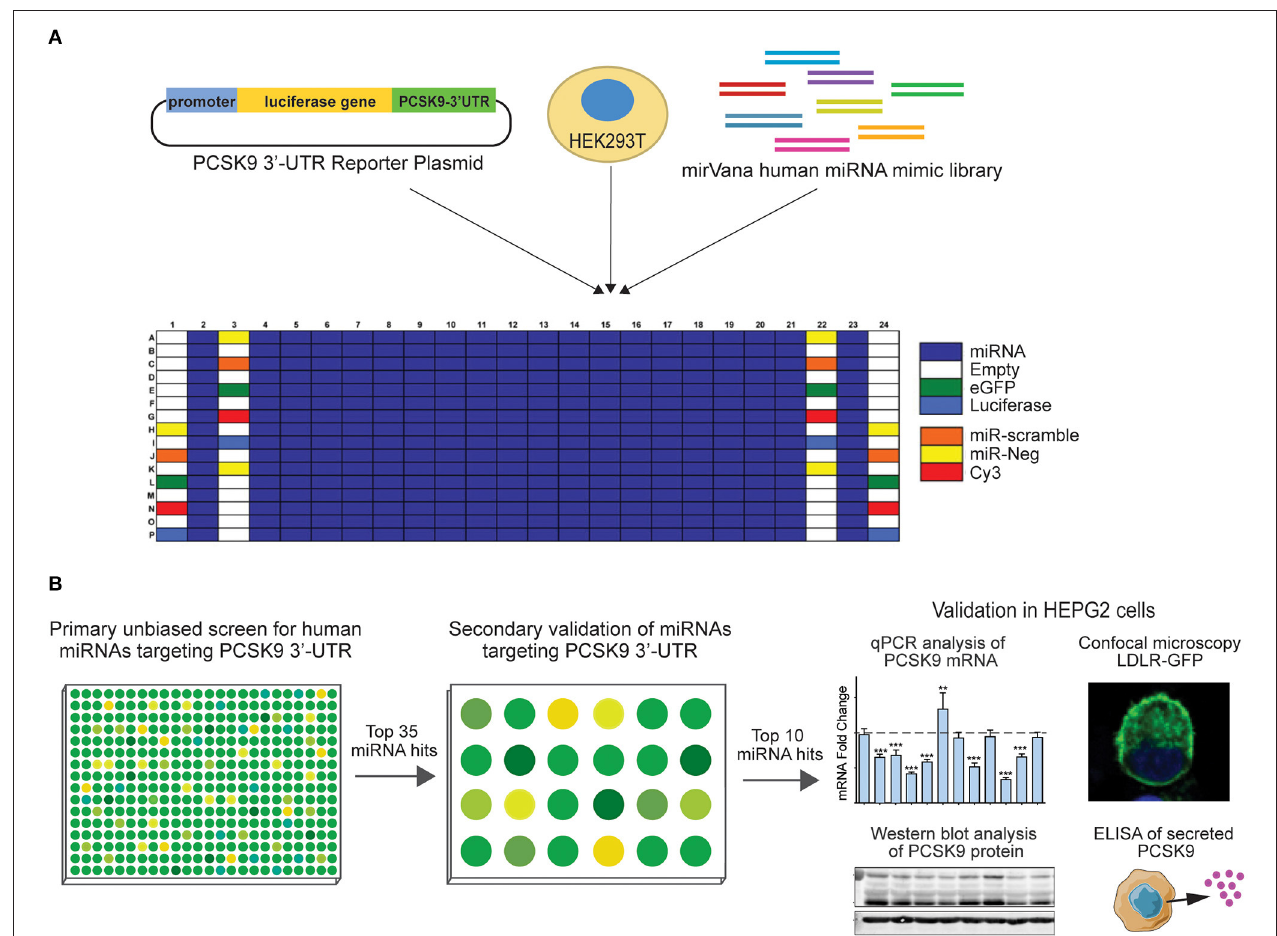
FIGURE 1 | Experimental design for high-throughput human miRNA library screen to identify novel miRNAs targeting PCSK9 . (A) Primary unbiased screen of human miRNAs targeting the 3 ′ -UTR of human PCSK9 . HEK-293T cells underwent reverse transfection with a luciferase reporter plasmid harboring the 3 ′ -UTR of PCSK9 , and a human miRvana miRNA mimic library in a 384-well array format. (B) Secondary screen of the top 35 miRNA hits using the same PCSK9 3 ′ -UTR-luciferase assay in a 24-well format and further validation of the top 10 candidates for effects on PCSK9 mRNA and protein expression, and low-density lipoprotein receptor (LDLR)